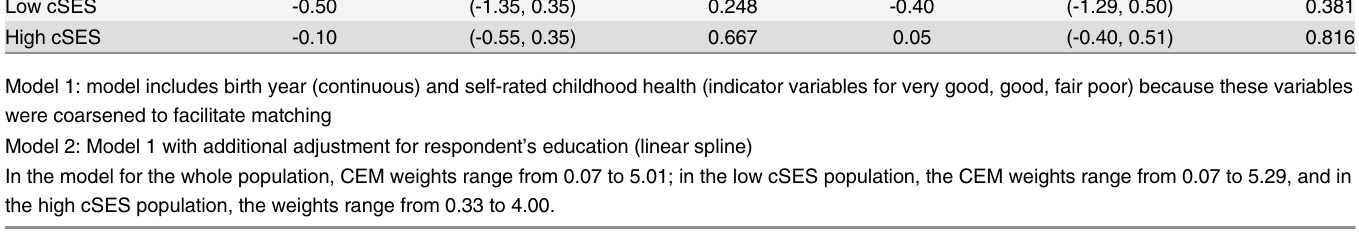
were coarsened to facilitate matching Model 2: Model 1 with additional adjustment for respondent ’ s education (linear spline) In the model for the whole population, CEM weights range from 0.07 to 5.01; in the low cSES population, the CEM weights range from 0.07 to 5.29, and in the high cSES population, the weights range from 0.33 to 4.00.